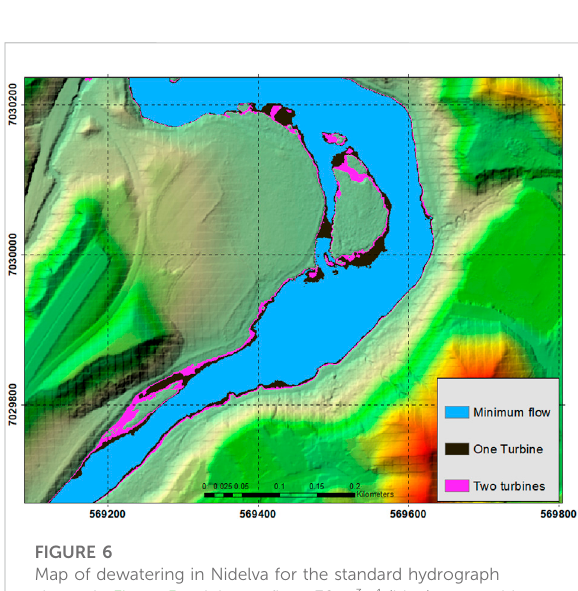
FIGURE 6 Map of dewatering in Nidelva for the standard hydrograph shown in Figure 5: minimum fl ow, 30 m 3 s − 1 (blue); one turbine, 80 m 3 s − 1 (black); and two turbines, 130 m 3 s − 1